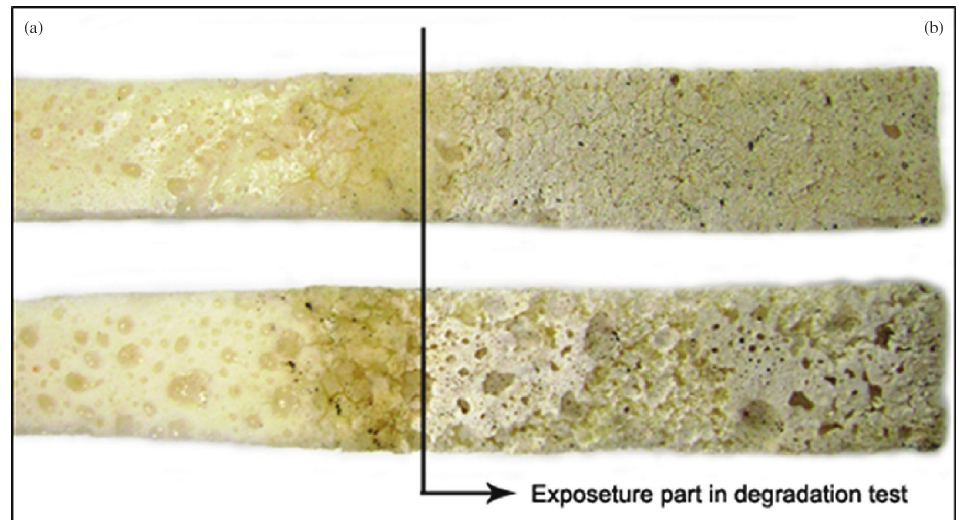
Figure 2. Photographic record of expanded test specimens of (a) E-PLA/EXO; and (b) E-PLA/ENDO after 90 days of exposure to simulated